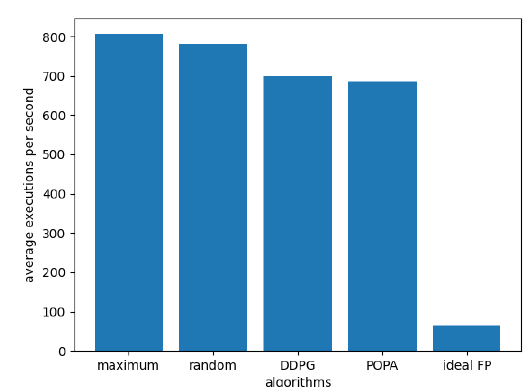
Figure 7. Comparison of the average executions per